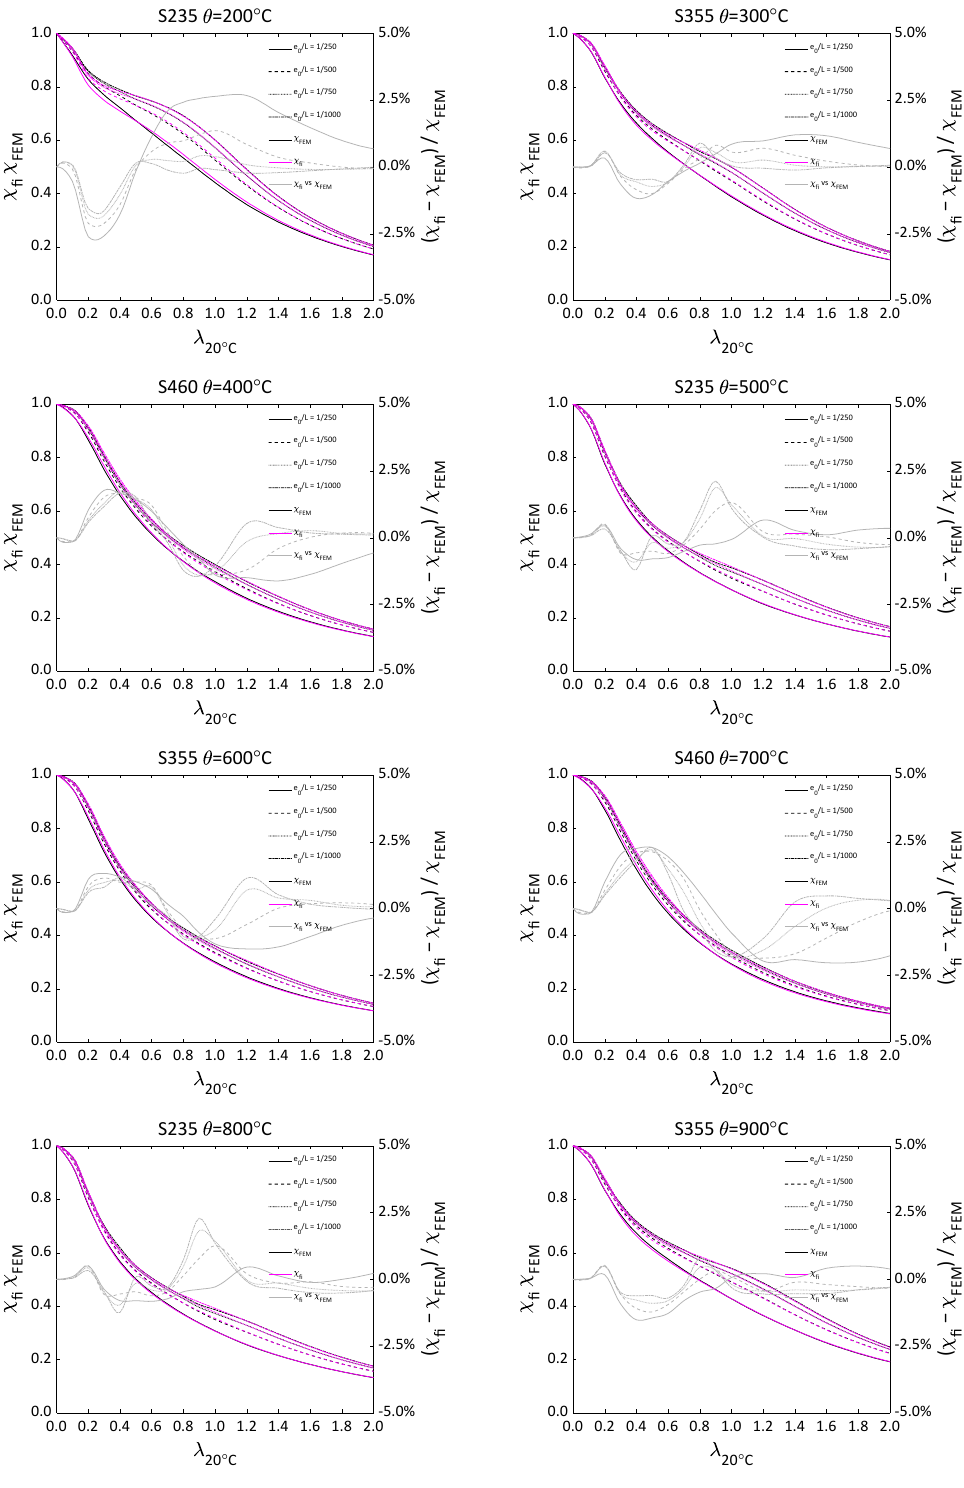
Figure 8. Performances of the proposed method against non-linear FEM after modification for different steel grades, heating temperatures and initial imperfection values.